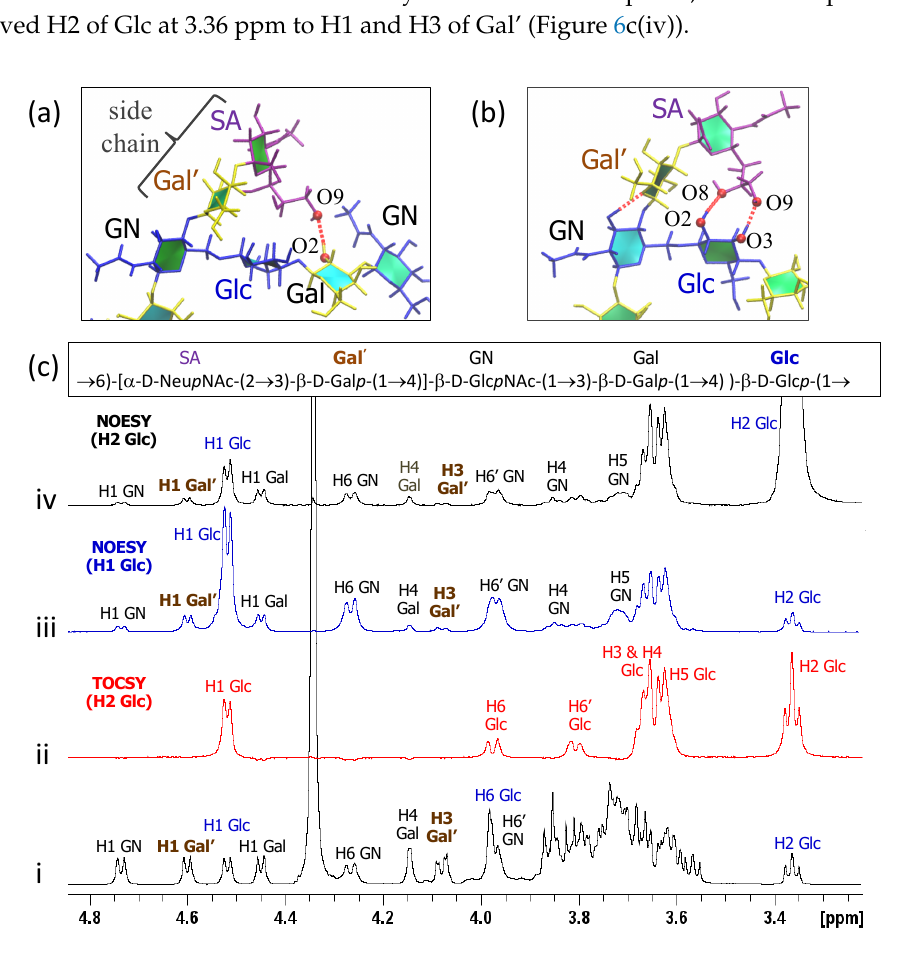
Figure 6. Inter-residue contacts in GBSIII PS. ( a ) Example of SA O9–Gal O2 hydrogen bond between the side chain and the backbone residues. ( b ) Example of simultaneous SA O9–Glc O3 and SA O8–Glc O2 hydrogen bonds. ( c ) Overlay of 1D NMR experiments of GBSIII PS showing ( i ) 1D proton spectrum; ( ii ) 1D TOCSY (200 ms) with irradiation of H2 Glc; ( iii ) 1D NOESY (500 ms) with irradiation of H1 Glc; and ( iv ) 1D NOESY (500 ms) with irradiation of H2